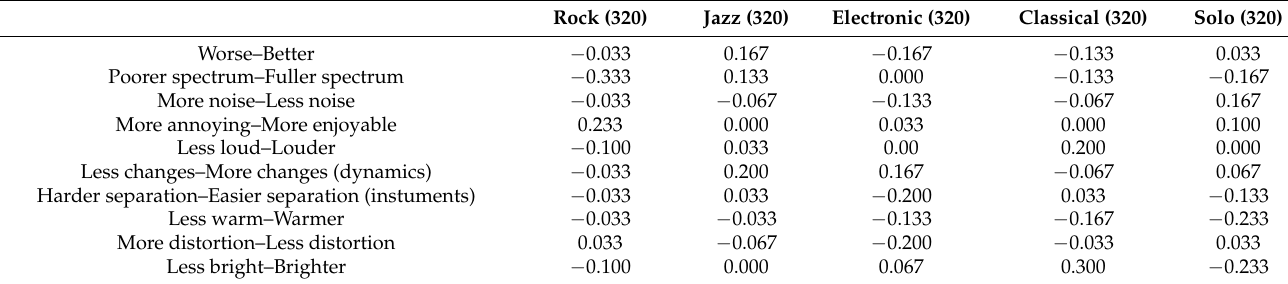
Table A5. Average evaluation scores for the bipolar scales for 320